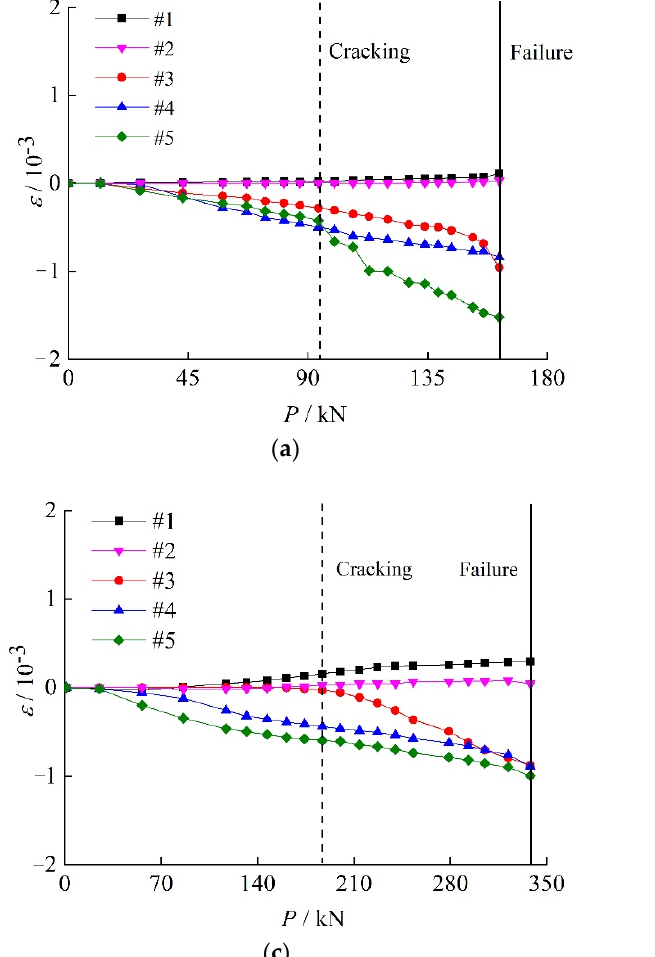
( h ) Figure 11. Strain development of specimens: ( a ) Clamp strain of P4B-CS-I, ( b ) Concrete strain of P4B-CS-I, ( c ) Clamp strain of P5A-CS-I, ( d ) Concrete strain of P5A-CS-I, ( e ) Clamp strain of P5C-CS- I, ( f ) Concrete strain of P5C-CS-I, ( g ) Clamp strain of P6A-CS-I, ( h ) Concrete strain of P6A-CS-I. 5. Finite Element Analysis A thorough nonlinear finite element analysis (FEA) was conducted using the pro- gram ABAQUS to forecast the response of the Combination Splice of PPCP employing HSSS under a flexural load. The FEA model is validated using the experimental findings.